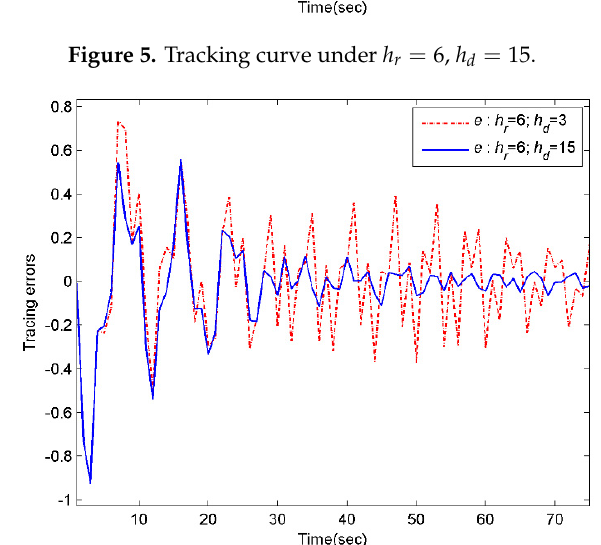
Figure 6. Tracking error curves under the same h r and di ff erent h d